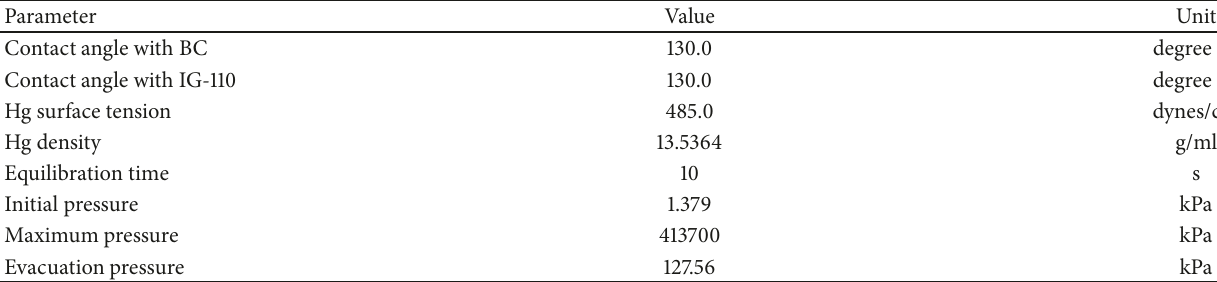
Table 1: HPMI test parameters.